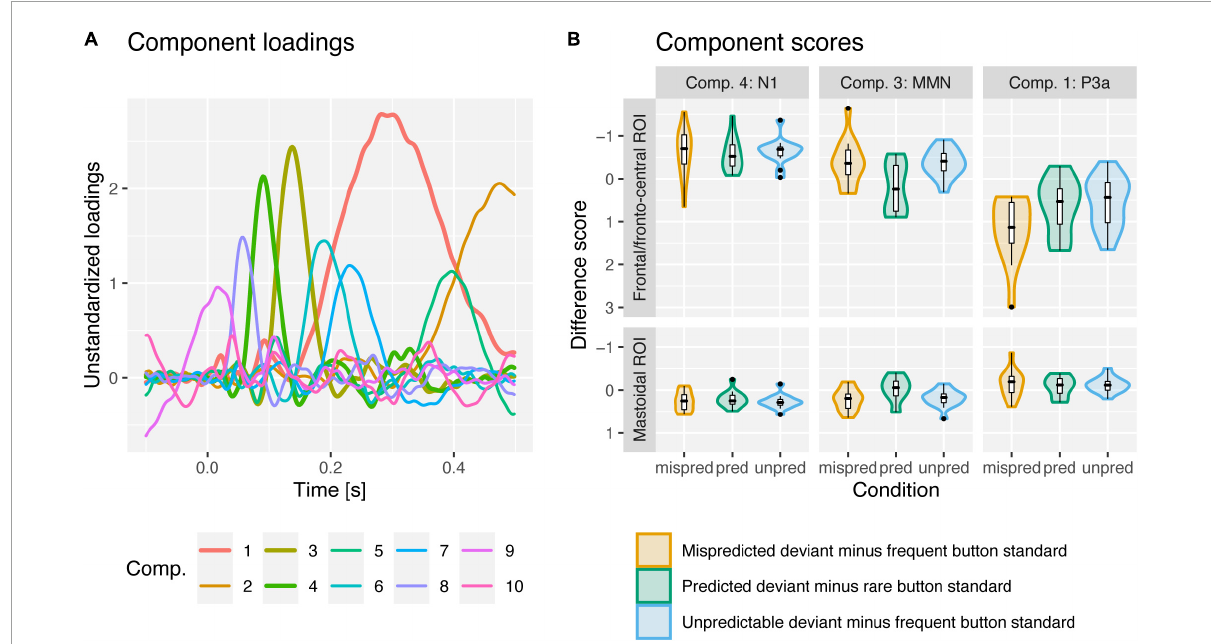
FIGURE3 PCA component loadings (A) and violin and boxplots for deviant minus standard difference component scores (B) for mispredicted (orange; minus frequent button standards) and unpredictable deviants (blue; minus frequent button standards) and predicted deviants (green; minus rare button standards) for PCA components N1, MMN and P3a at frontal and mastoidal (N1 and MMN) and fronto-central ROIs (P3a). PCA components 4, 3, and 1 were associated with the N1, MMN and P3a ERP-components. N1 was enhanced (more negative at frontal, more positive at mastoidal electrode sites) for deviants compared to standards similarly in all conditions. MMN was observed for mispredicted and unpredictable deviants but abolished for predicted deviants. P3a was observed in all conditions but enhanced (more positive at fronto-central electrode sites) in response to mispredicted deviant compared to predicted and unpredictable